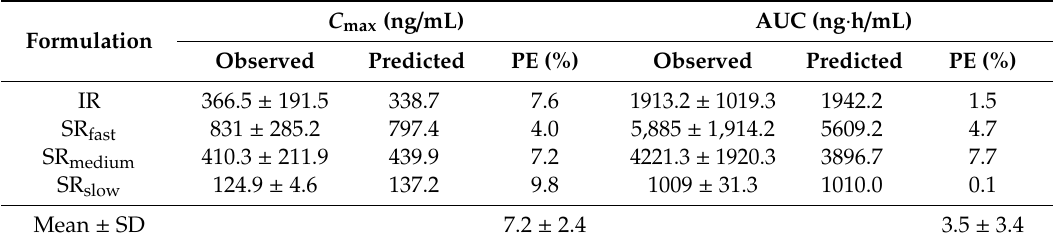
Figure 6. Estimation of the in vivo plasma concentration versus time profiles after oral administration of sildenafil ( A ) IR, ( B ) SR fast , ( C ) SR medium , and ( D ) SR slow tablets by the in vitro-in vivo correlation (IVIVC) model. Table 5. Prediction error (%PE) for C max and area under the plasma concentration-time curve (AUC) of sildenafil obtained from IVIVC modeling.